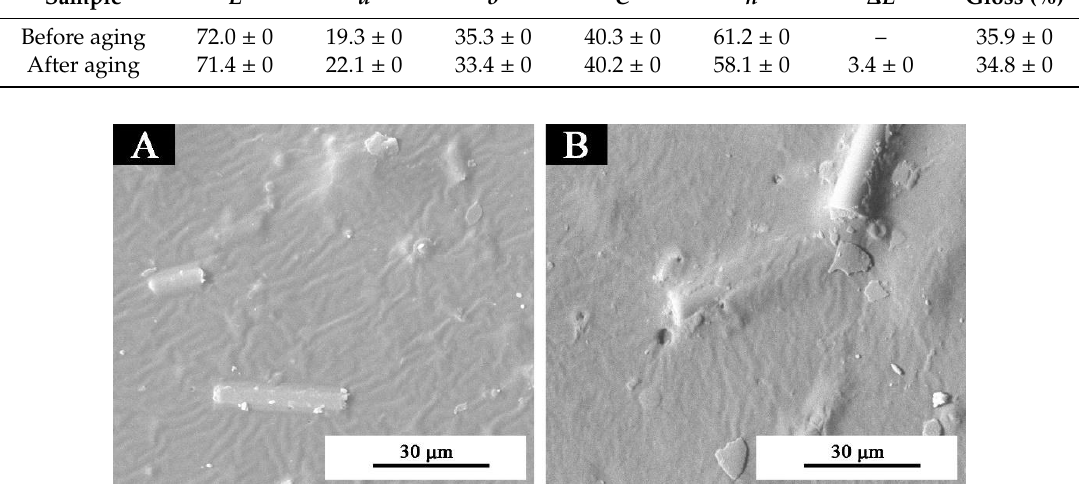
Table 11. Gloss and chromatic values of waterborne wood coating before and after aging.